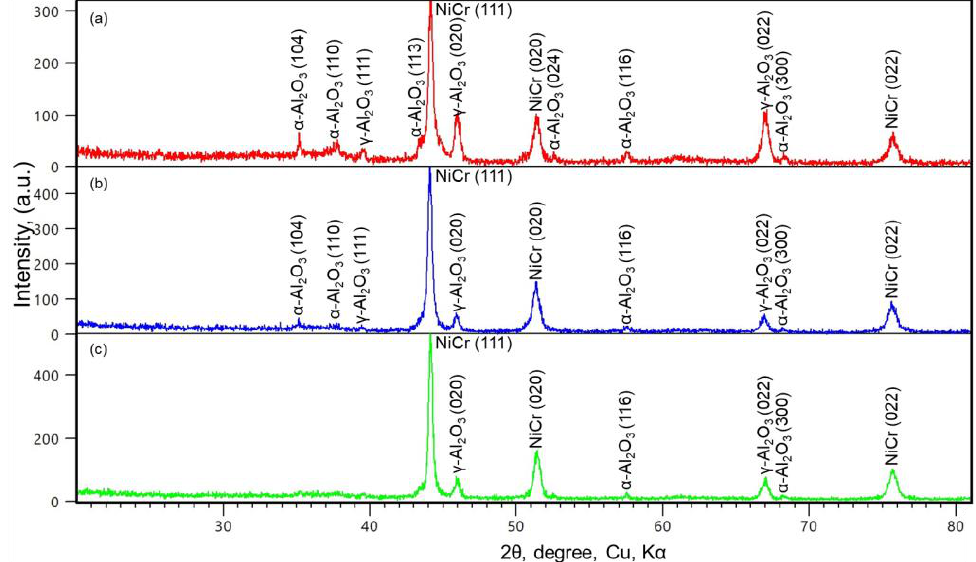
Figure 3. Diffractograms of multilayer gradient coatings corresponding to the acquisition of information from a depth of 20 – 30 µm: ( a ) three-layer coating, ( b ) five-layer coating, ( c ) six-layer coating.